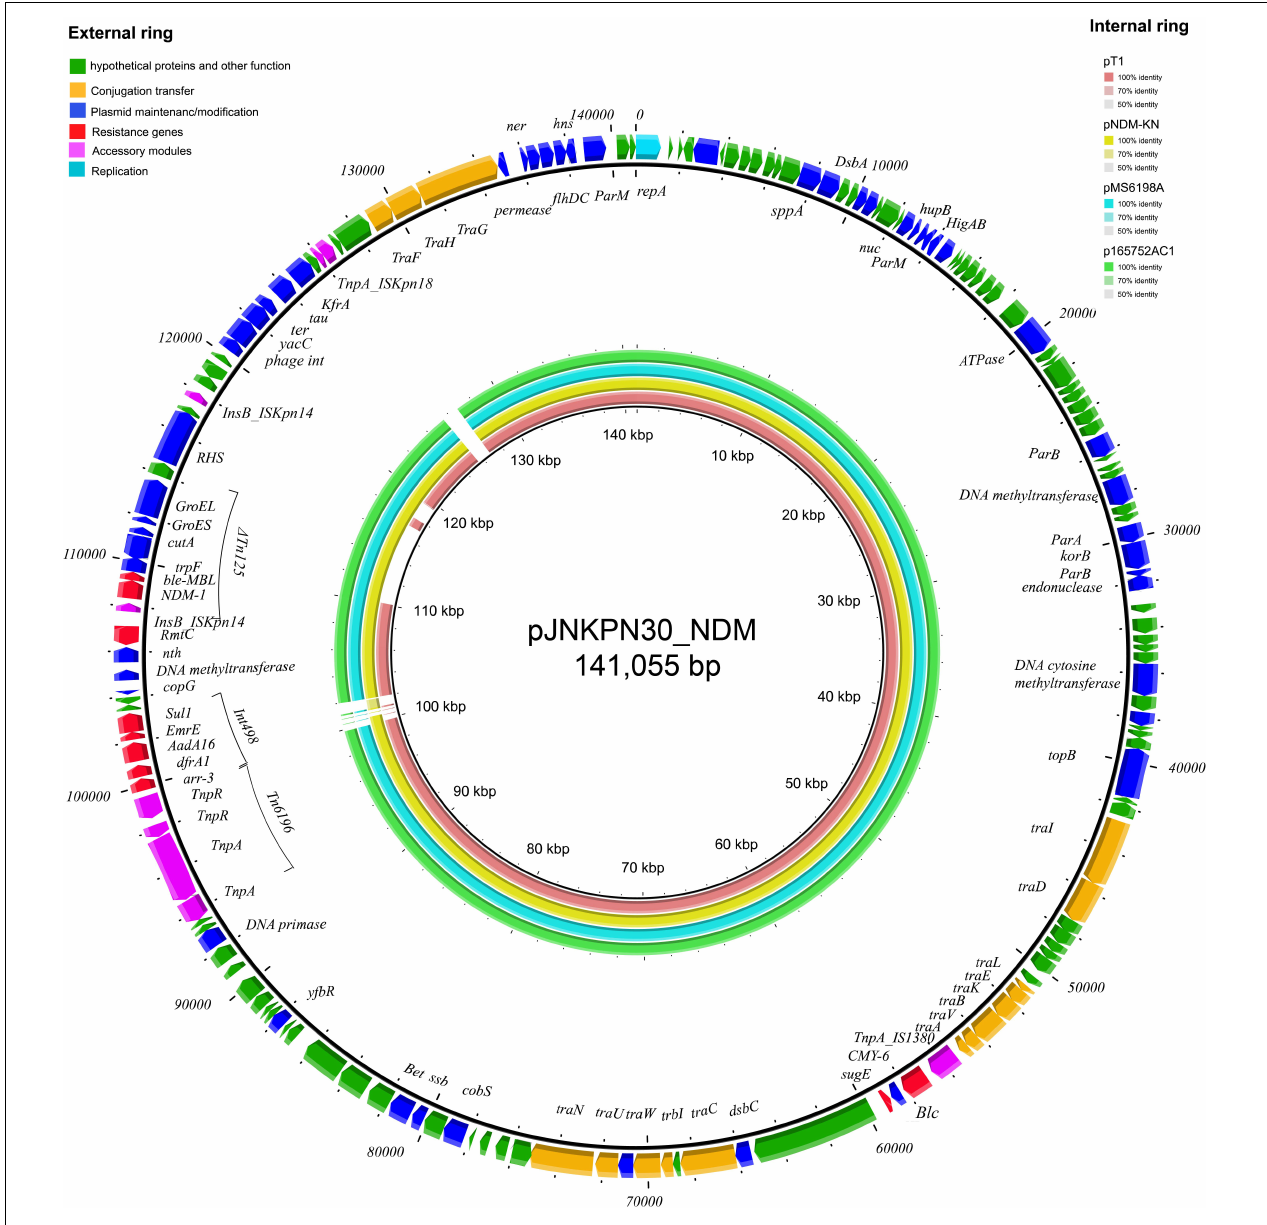
FIGURE 8 | The external ring is the main structural feature of plasmid pJNKPN30_NDM (GenBank accession no. OL389795). The internal four rings showed the comparative analysis of bla NDM -harboring plasmids with pJNKPN30_NDM (constructed by